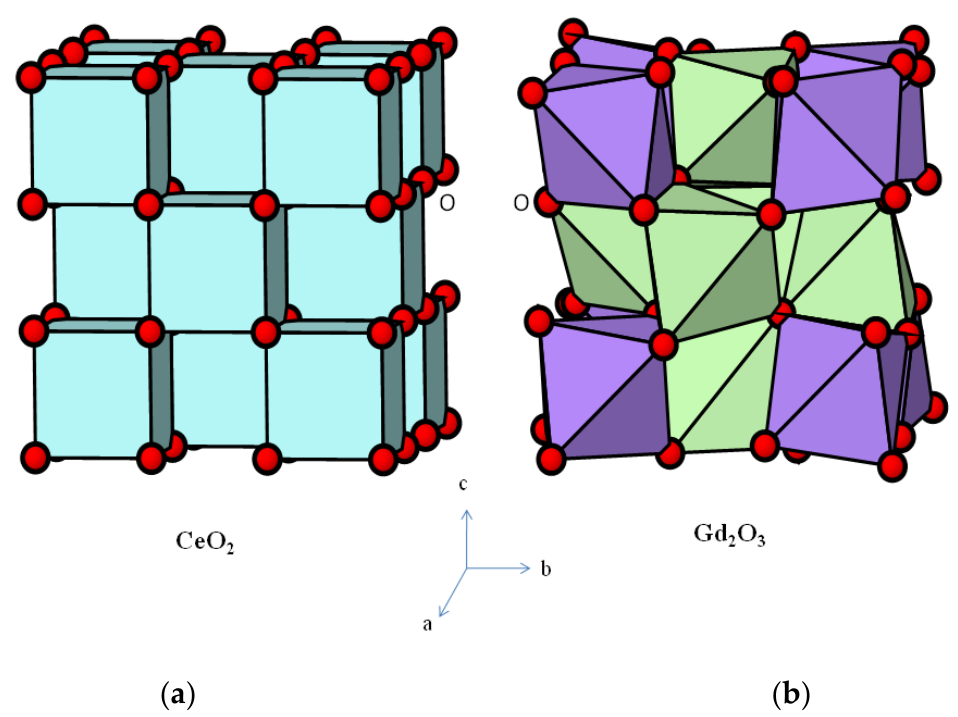
Figure 2. Crystal structures of ( a ) CeO 2 (F phase) and ( b ) Gd 2 O 3 (C phase). To make the comparison easier, only one eighth of the Gd 2 O 3 unit cell is drawn. The lanthanide element is located at the center of each polyhedron. Reprinted with permission from ref [31]. Copyright 2021 Elsevier License Terms And Conditions.